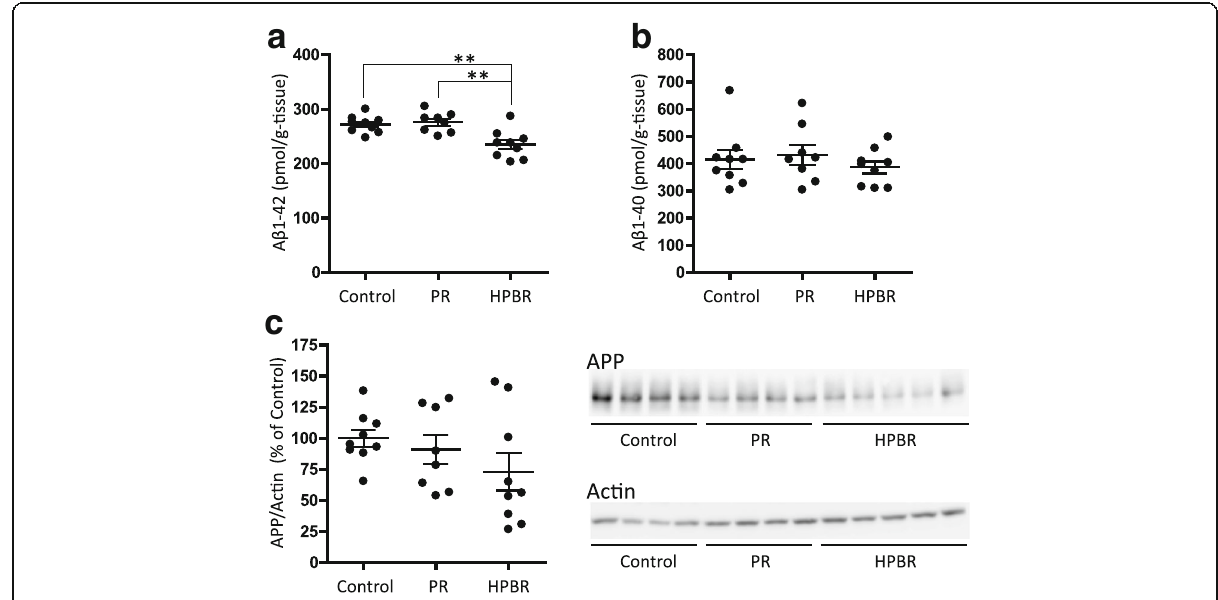
Fig. 5 The amounts of A β and APP in the brain. a A β 1 – 42 . P = 0.004, one-way ANOVA and ** P < 0.01, HPBR vs. control or PR, Dunnett ’ s post-test. b A β 1 – 40 . P = 0.54, one-way ANOVA. c APP and its representative image of western blotting. P = 0.26, one-way ANOVA. PR: Polished rice, HPBR: highly water pressurized brown rice. Mean ± SE, n = 9 (control and HPBR groups) or 8 (PR